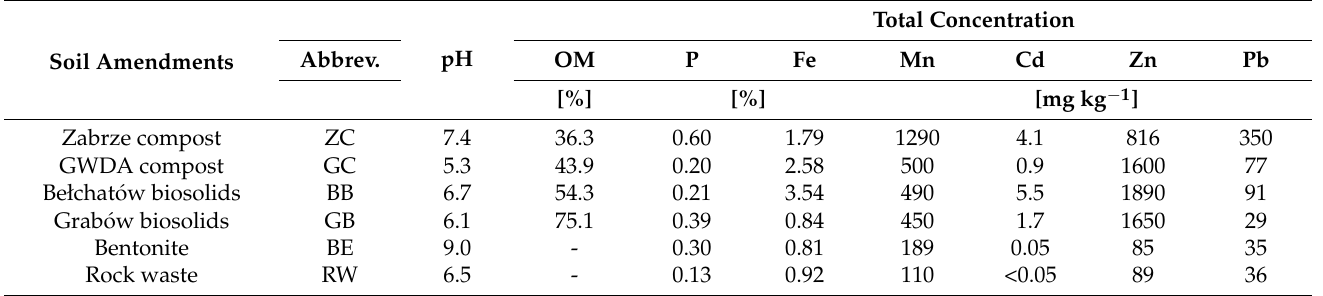
Table 1. Physicochemical properties of the soil